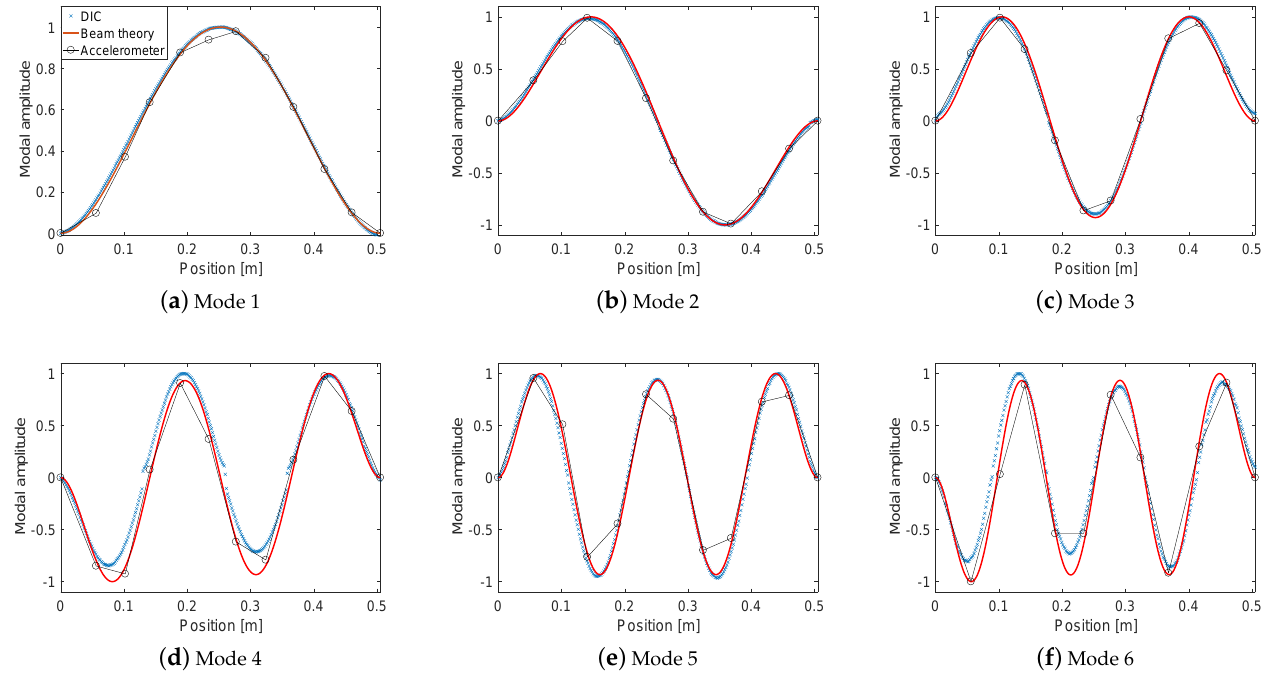
Figure 20. Comparison of the first six mode shapes of the clamped–clamped beam for a particular test. To validate the use of the DIC to perform modal analysis, we can compare the eigen frequency and modal damping ratio values obtained to those determined using the ac- celerometer measurements. The mode shapes can also be compared to theoretical or numerical ones. To this end, the Modal Assurance Criterion (MAC) is commonly used [27]. This criterion is defined as the normalized scalar products of the mode shapes. The i th mode of a family A is compared to the j th mode of a family B , and the resulting scalar is arranged into the MAC matrix as